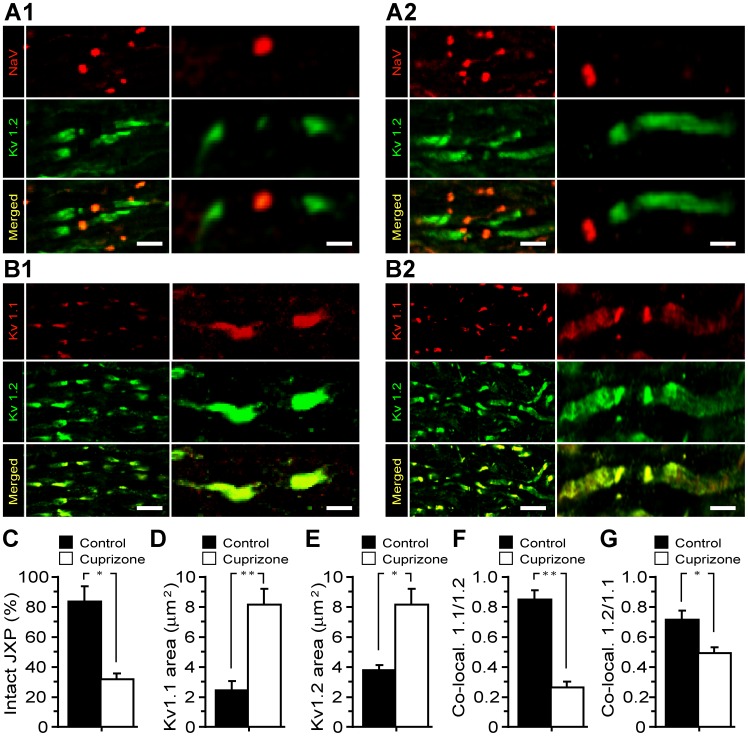
Demyelination alters the distribution and composition of KV1 channels in ON.Double [pan-Na (red)/KV1.2 (green)] immuno-labelling of control (A1) and experimental (A2) ON: note elongated JXPs with alterations in most of the nodal NaV channel clusters in samples from the cuprizone-treated mice. (B1–2) Double immuno-labelling of ON for KV1.1 (red) and KV1.2 (green) subunits of KV1 channels: control (B1) and experimental (B2) samples, respectively. Note the highly localized occurrence of these proteins in JXPs of controls contrasting with their diffuse location along the ON axons in demyelinated specimens. Yellow staining corresponds to JXP regions showing co-localization of these proteins. The scale bars for low and high magnifications are 6 and 2 µm, respectively. (C) Summary histogram of the intact JXP labelled with anti-KV1.2 antibody of control and experimental ON axons (n = 3 in each group). (D) A plot of the mean area of JXPs labelled for KV1.1 channels in control (2.4±0.5 µm2) compared to the increased area of fluorescence intensity of JXPs in demyelinated (8.2±1 µm2) axons. (E) The mean fluorescence area of JXPs labelled for Kv1.2 channels in control (3.8±0.4) was lower than that in the treated ON axons (8.2±1 µm2). (F) A summary histogram of KV1.1 and 1.2 co-localization in control (0.86±0.06) and demyelinated (0.27±0.04) ON demonstrating a significant (p<0.001) reduction in the degree of KV1.1/1.2 co-localization in ON axons of the experimental mice. (G) The degree of KV1.2/1.1 co-localization in ON axons of the experimental mice showed a reduction, which is still significant (P<0.05), when comparing the control (0.71±0.06) and the demyelinated ON (0.49±0.04) values. Data are taken from control and demylinated ON axons of 3 animals, in each group.